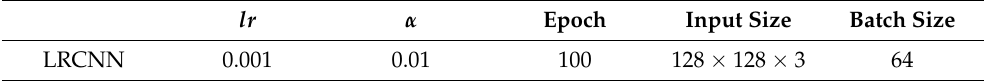
Table 2. Hyperparameters for the LRCNN.